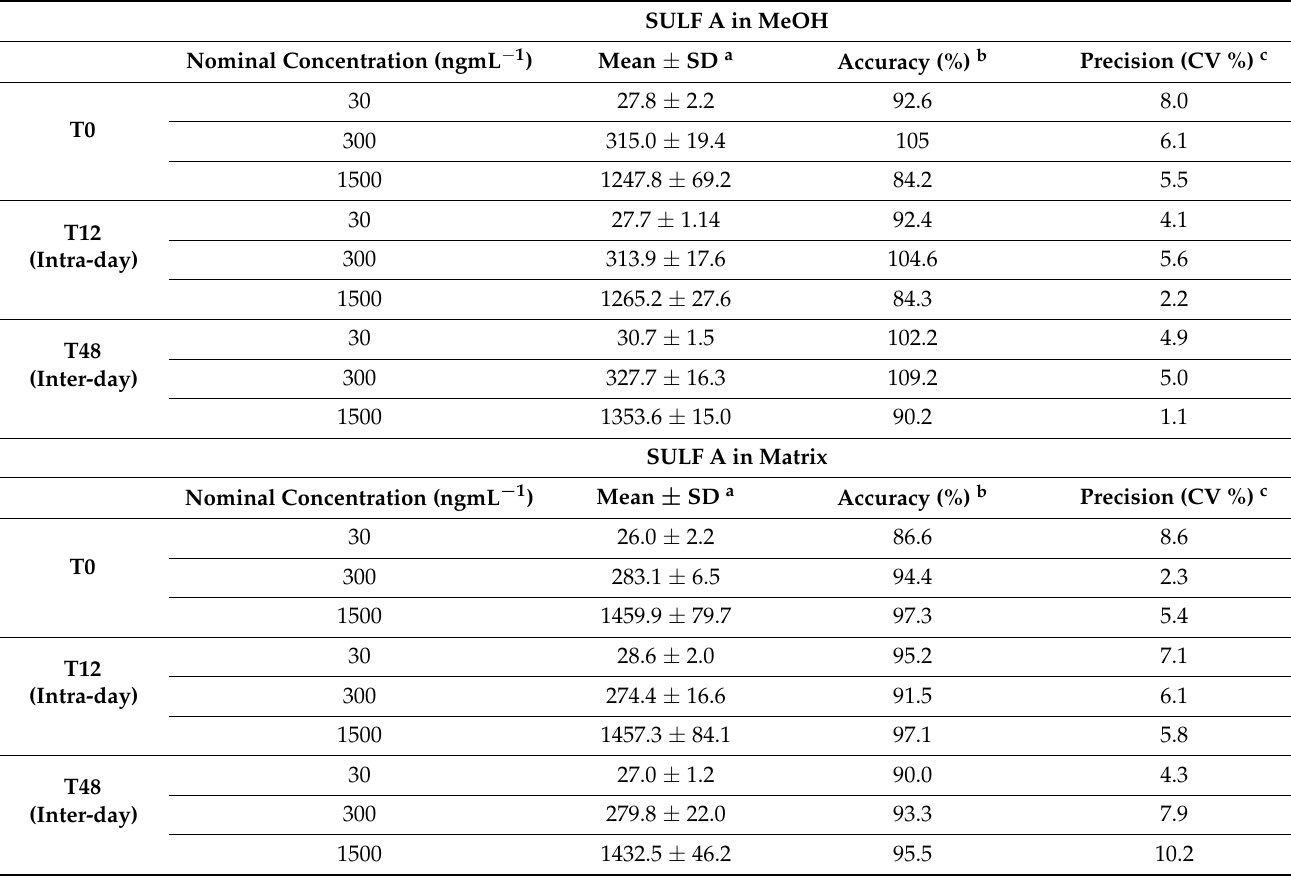
a SD = Standard Deviation b [Measured mean concentration/ nominal concentration] × 100. c [Standard deviation/ measured mean concentration] × 100.